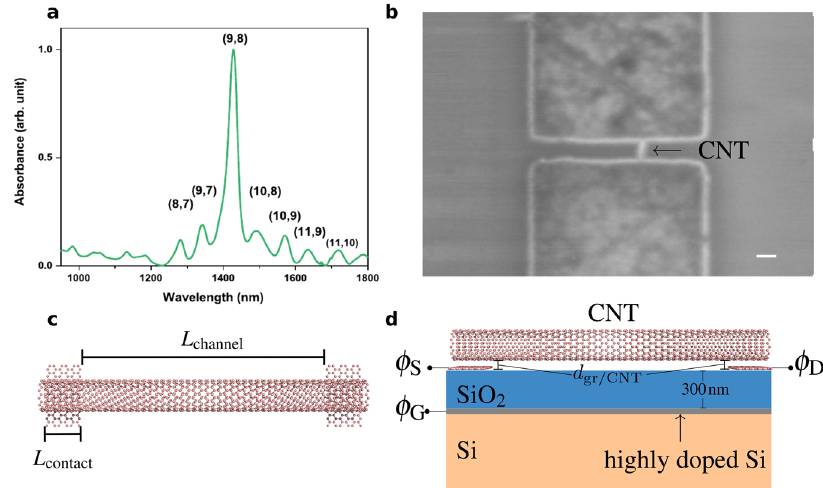
Fig. 1 Fabricated all-carbon transistor devices and their virtual counterparts. a The predominant chirality of the carbon nanotubes (CNT) is (9,8) as seen from the absorption spectrum of the CNT suspension, where the 1400 nm peak corresponds to the (9,8)-CNTs. b Scanning electron micrograph of a graphene-CNT-graphene device. An approximately 100 nm long CNT bridges the graphene source- and drain-electrodes. Scale bar: 100 nm. c In the virtual all-carbon transistor, the CNT channel and graphene electrodes are treated quantum-mechanically at the atomistic level. The channel- and contact length is given by L channel and L contact , respectively. d Schematic view of the all-carbon fi eld effect transistor. The CNT/graphene spacing is denoted with d gr/CNT and the graphene layers serve as the source- ( ϕ S ) and drain- ( ϕ D ) electrodes, respectively. The gate-electrode is denoted with ϕ G . The SiO 2 oxide layer is 300 nm thick (orange) and isolates the carbon system from the highly doped Si gate electrode on top of the Si substrate